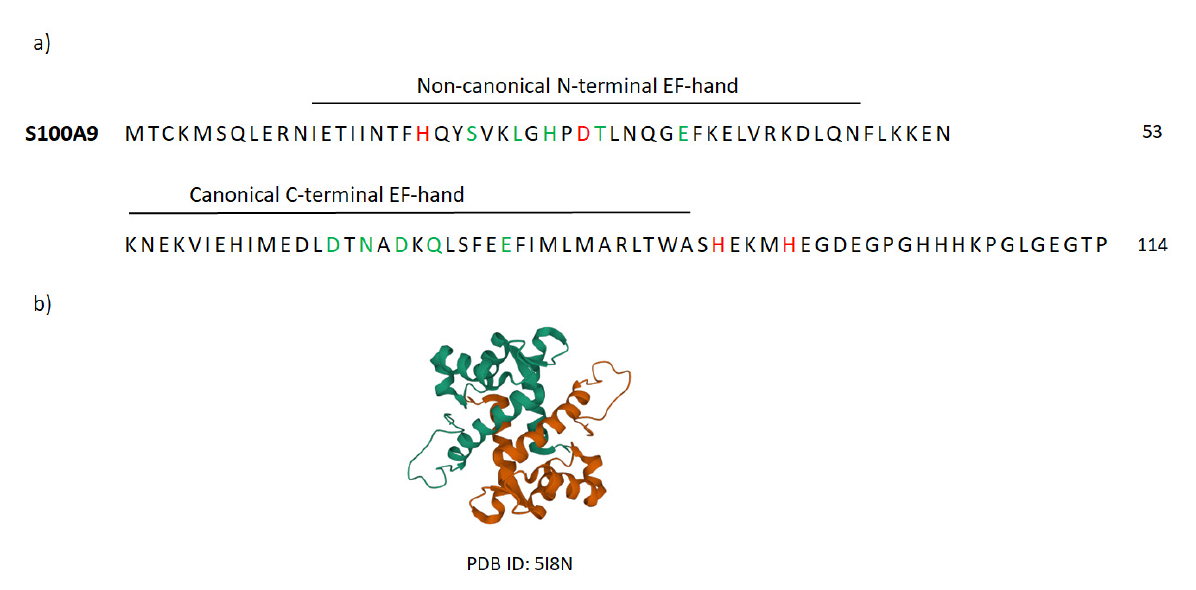
Figure A4. Structures of S100A9 protein: ( a ) predicted amino acid sequence of the human S100A9 (the red color marks those amino acids that bind Zn 2+ , while the green color marks the amino acids that bind Ca 2+ ); ( b ) solution structure of human calcium-binding S100A9 (C3S) protein—image from the RCSB PDB (rcsb.org) of PDB ID 5I8N [274].